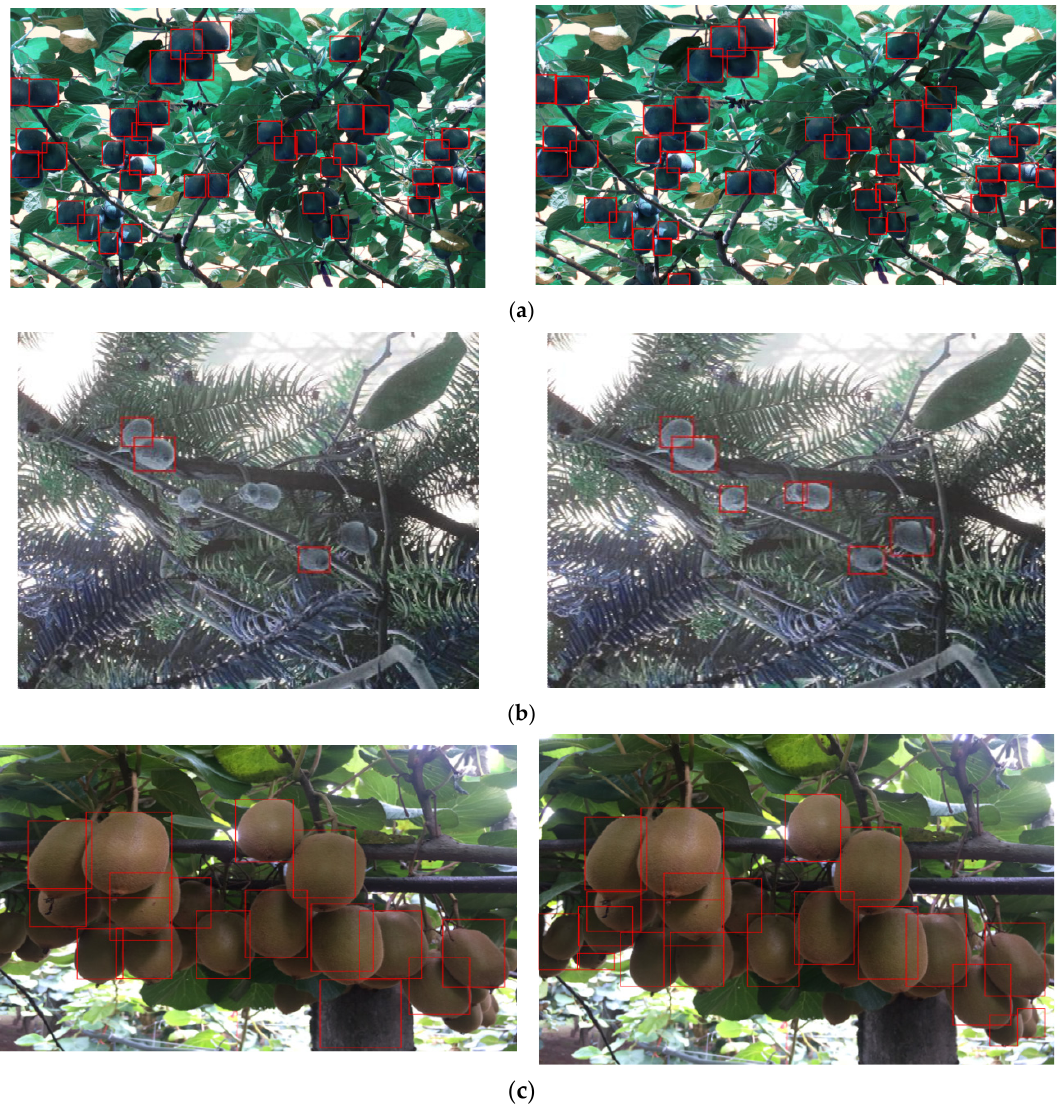
Figure 11. ( a ) Enhancement of fruit recognition under tree trunk and leaf occlusion. ( b ) Enhancement of low-density fruit missed recognition. ( c ) Enhancement of non-target fruit misrecognition.